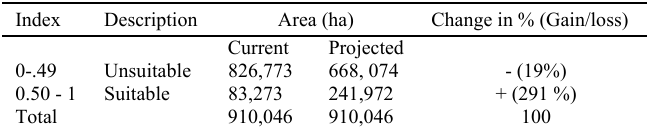
Fig. 6: Current of projected suitability map of Piper spp. in Bukidnon Table 3. Changes in habitat suitability